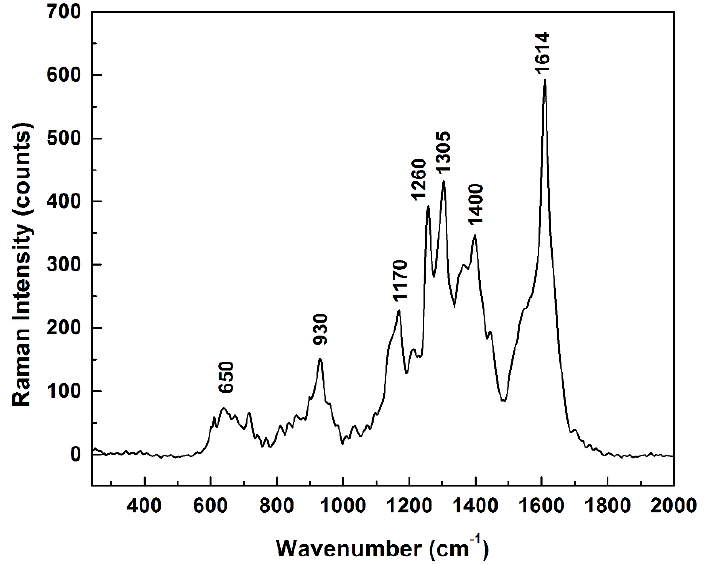
Figure 7. Overall average of 400 Raman spectra recorded in different spots on the sample (8 different time series acquisitions, of 50 spectra each and at 200 ms per spectrum).